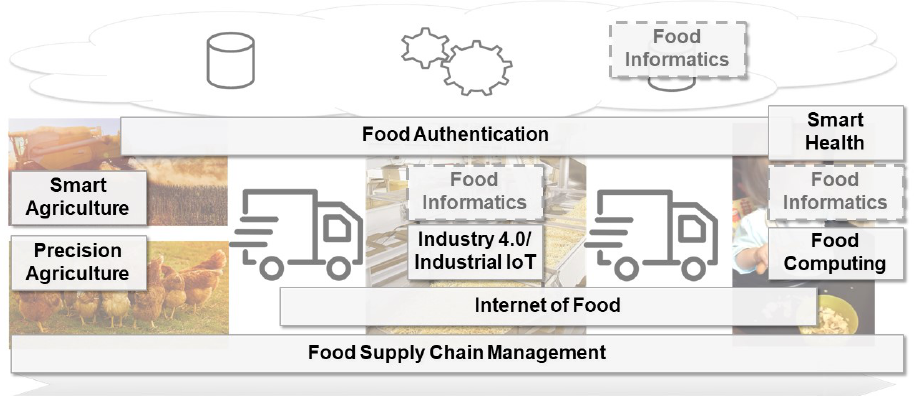
Figure 2. Presented scientifc concepts mapped to the food supply